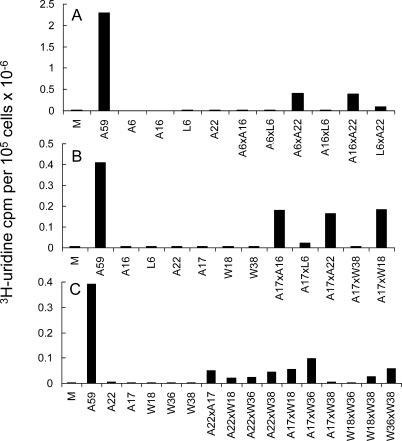
Biochemical Complementation Analysis of Selected MHV-A59 ts MutantsCells were mock-infected or infected with MHV-A59, one of the ts mutants, or with a mixture of two ts mutants. The cells were incubated at 40 °C in medium containing dactinomycin and 3H-uridine and, at 8 hpi, 3H-uridine incorporation into trichloroacetic acid-precipitated RNA was determined. Cells were infected with: M, mock-infected; A59, MHV-A59; A6, Alb ts6; A16, Alb ts16; A22, Alb ts22; A17, Alb ts17; L6, LA ts6; W18, Wü ts18; W36, Wü ts36; W38, Wü ts38; A6xA16, Alb ts6 and Alb ts16; A6xL6, Alb ts6 and LA ts6; A6xA22, Alb ts6 and Alb ts22; A16xL6, Alb ts16 and LA ts6; A16xA22, Alb ts16 and Alb ts22; L6xA22, LA ts6 and Alb ts22; A17x A16, Alb ts17 and Alb ts16; A17xL6, Alb ts17 and LA ts6; A17xA22 or A22xA17, Alb ts17 and Alb ts22; A17xW38, Alb ts17 and Wü ts38; A17xW18, Alb ts17 and Wü ts18; A17xW36, Alb ts17 and Wü ts36; A22xW18, Alb ts22 and Wü ts18; A22xW36, Alb ts22 and Wü ts36; A22xW38, Alb ts22 and Wü ts38; W18xW36, Wü ts18 and Wü ts36; W18xW38, Wü ts18 and Wü ts38; W36xW38, Wü ts36 and Wü ts38.